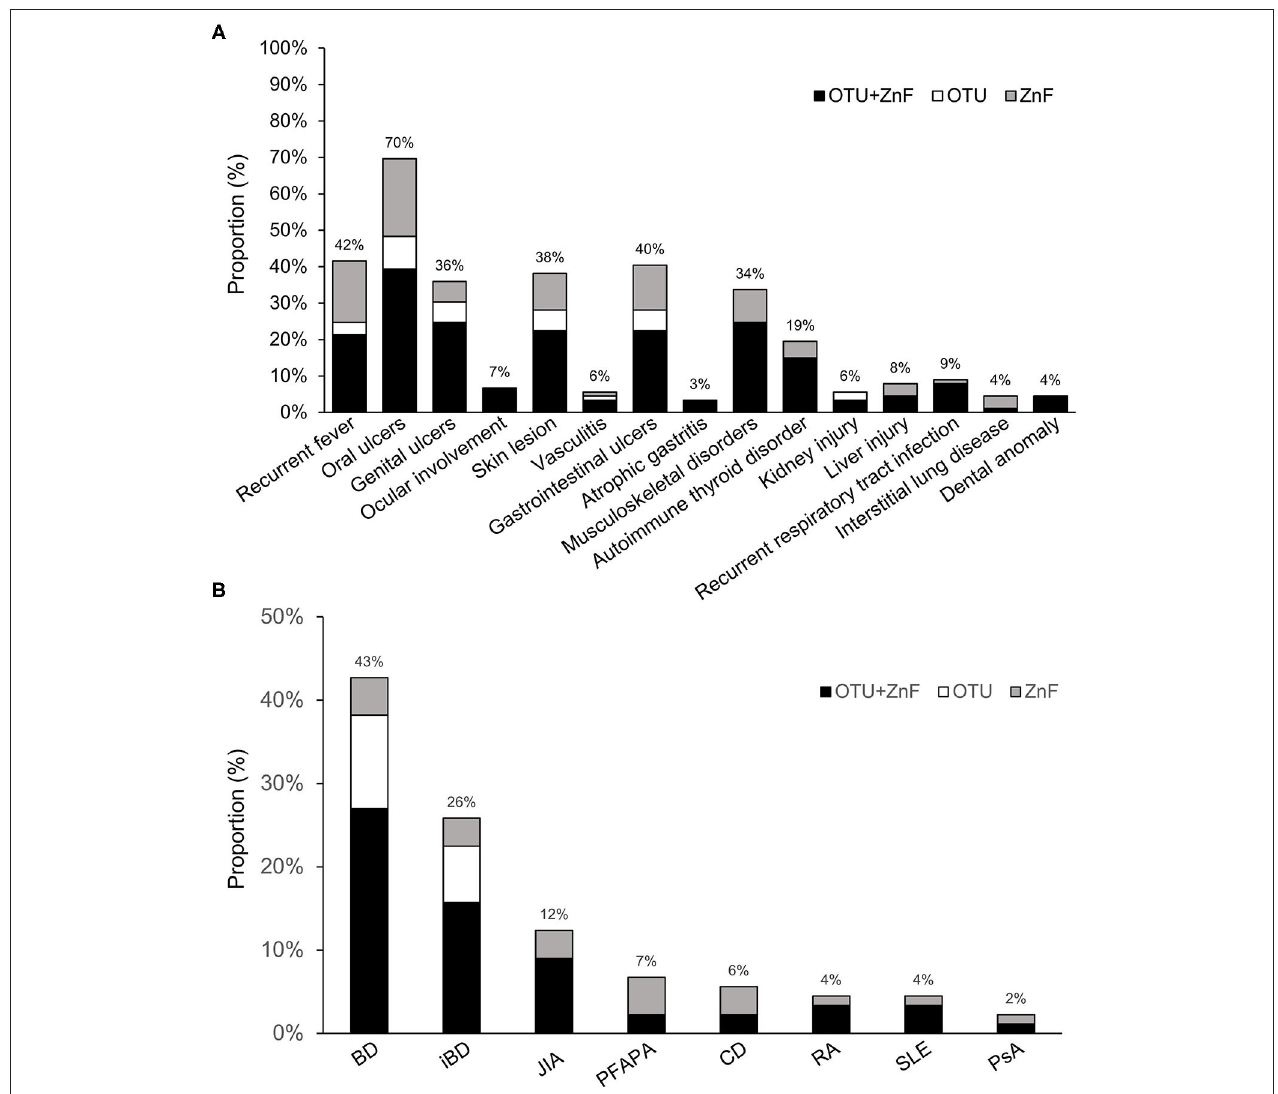
FIGURE 2 | Statistics of clinical manifestation in patients with HA20. (A) The percentage of various symptoms of HA20 in 89 patients. Patients were classified into the OTU + ZnF group, the OTU group and the ZnF group according to three types of A20 disruption. Except for interstitial lung disease, the patients with specific symptom of HA20 were mainly from OTU + ZnF group. (B) The proportion of initial diagnosis in HA20 and the distribution of each diagnosis in three groups.